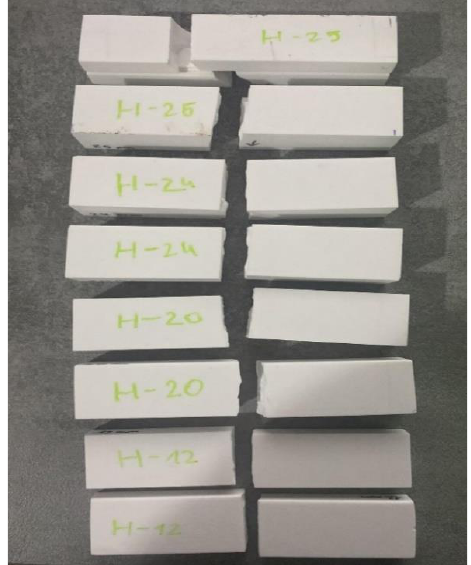
Figure 11. Glued artificial stone samples after bending test. Under the right bending conditions and exposed to temperatures, artificial stone breaks elastically, very similarly to plastic — even leaving white marks at the fracture site. However, in this study, the artificial stone was not exposed to temperature, resulting in specimens breaking as standard brittle materials. The last step of this experiment is to calculate and compare the mean flexural strength of the samples H − 12, H − 20, H − 24, and H − 25 during fracture (Figure 12).